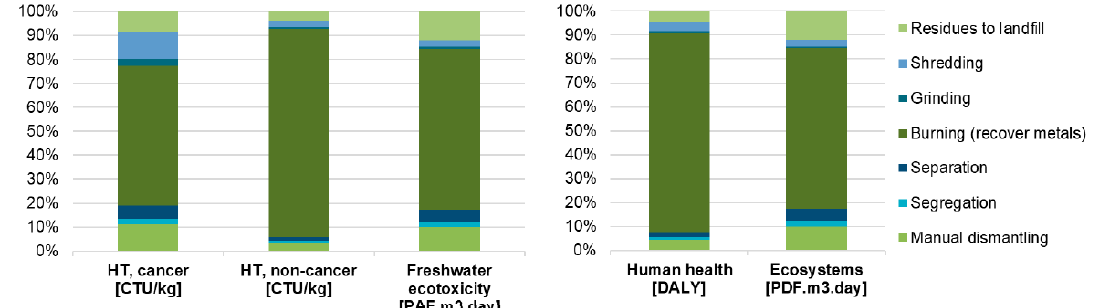
Figure 4. Environmental impacts associated with the informal treatment of WEEE, with evidence of the impacts related to the individual process steps for 1 kg of e-plastics (left: USEtox mid-point results for the “human toxicity, cancer”, “human toxicity, non-cancer”, and “freshwater ecotoxicity” impact categories; right: USEtox end-point results for the “human health” and “ecosystems” damage categories.